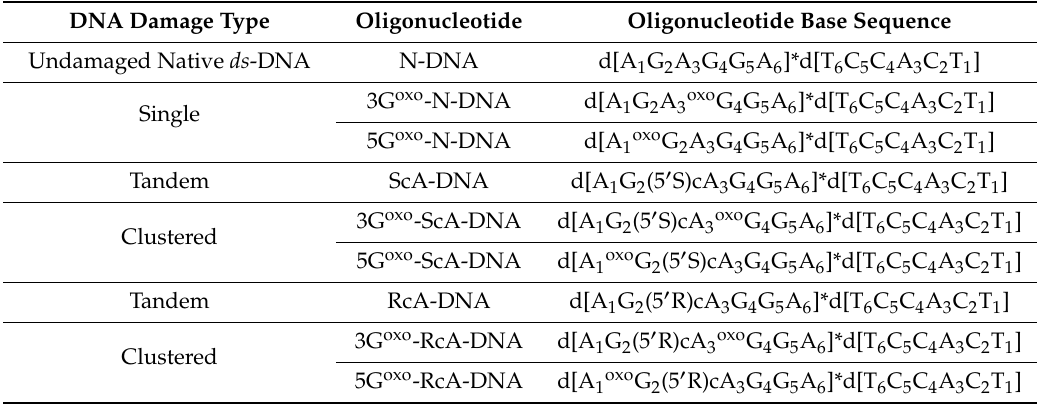
Table 1. Nucleobase sequence “structures” of double-stranded oligonucleotides taken into theoretical consideration. oxo G - 8-oxo-7,8-dihydro-2 (cid:48) -deoxyguaosie, (5 (cid:48) S )-cA: (5 (cid:48) S )-5 (cid:48) ,8-cyclo-2 (cid:48) -deoxyadenosine, (5 (cid:48) R )-cA: (5 (cid:48) R )-5 (cid:48) ,8-cyclo-2 (cid:48)